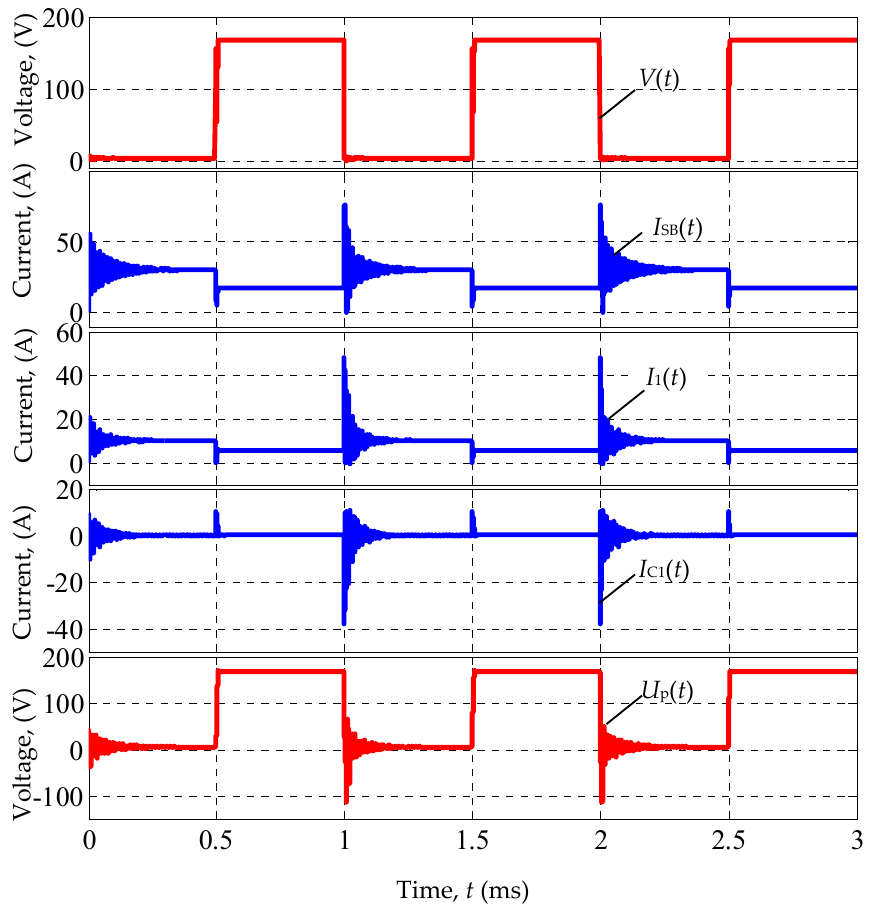
Figure A3. Transient processes in a solar cell at a frequency of 1 kHz.